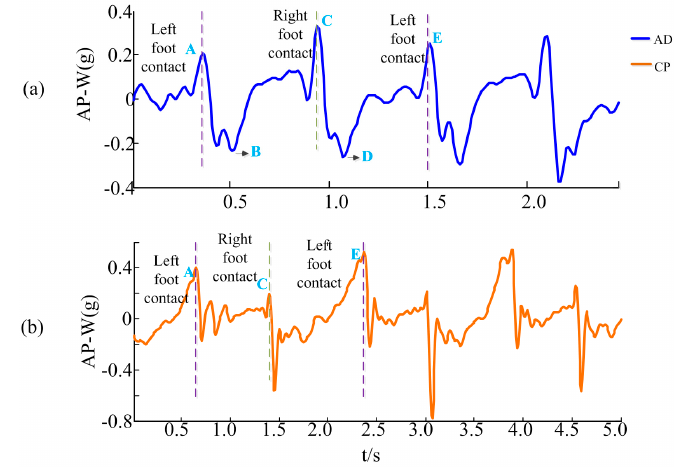
Figure 2. Gait acceleration from ( a ) a healthy subject; ( b ) a CP child.